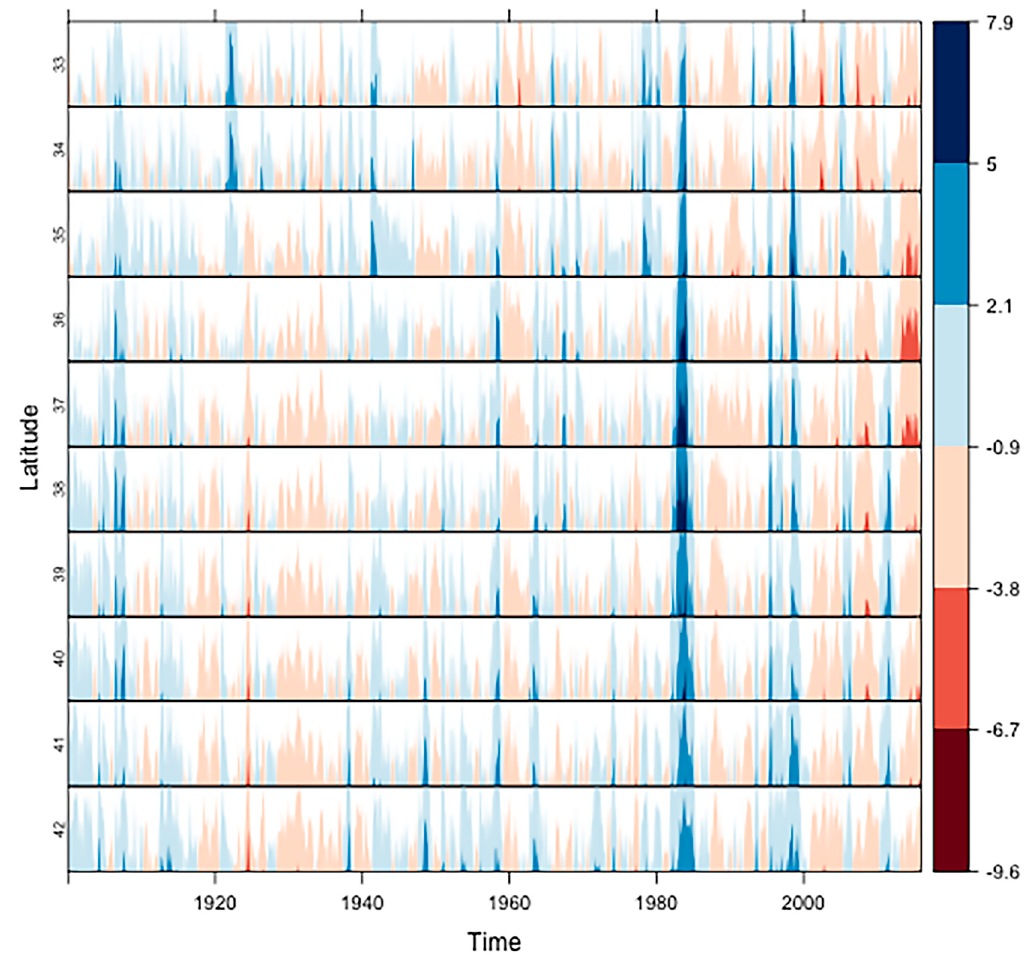
Figure 2. Mean monthly scPDSI for all forested areas within California by latitude. The 2012–2016 drought was the most severe on record in terms of drought severity and duration. Table 1. Federally funded datasets were used to evaluate patterns in tree mortality across California forests. Data was obtained from the National Aeronautics and Space Administration (NASA), the